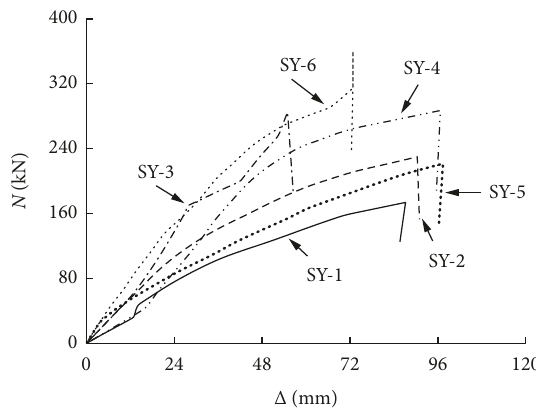
Figure 3: Load-displacement curve of screw